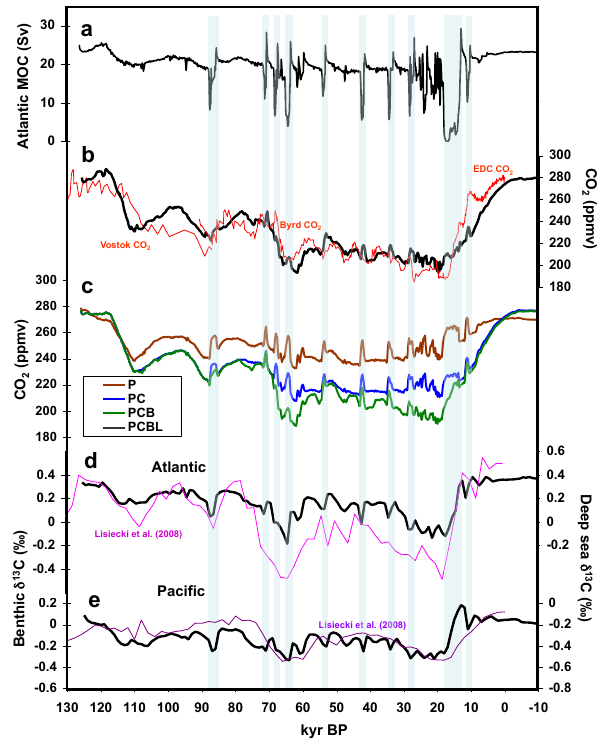
Fig. 2. Comparison of model results with geological records: (a) simulated Atlantic meridional overturning circulation in Sv; (b) atmospheric CO 2 concentration, simulation PCBL (thin black line), and Antarctic ice core reconstructions (Ahn and Brook, 2008; Barnola et al., 1987; Monnin et al., 2004) (thin red lines) in ppmv; (c) atmospheric CO 2 concentration for simulations P, PC, and PCB (brown, blue, and green lines, respectively) in ppmv; (d) deep-sea δ 13 C for simulation PCBL (thick black line) and geological stack record for the Atlantic Ocean (Lisiecki et al., 2008) (thin pink line) in ‰; (e) the same as (d) but for Pacific Ocean.